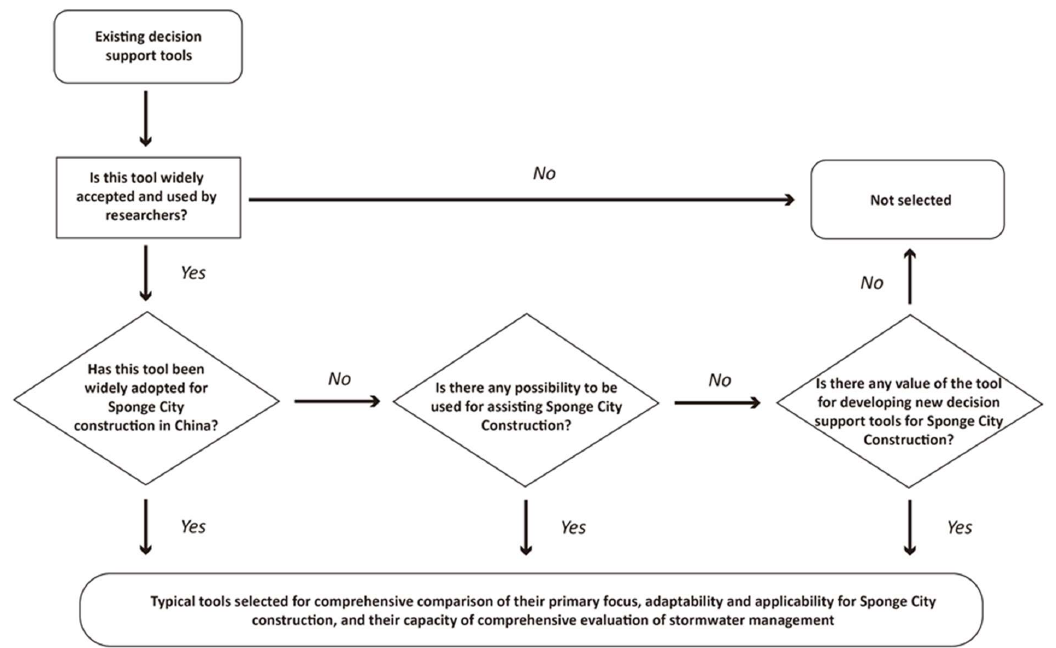
Figure 5. The flow chart of screening suitable decision support tools.